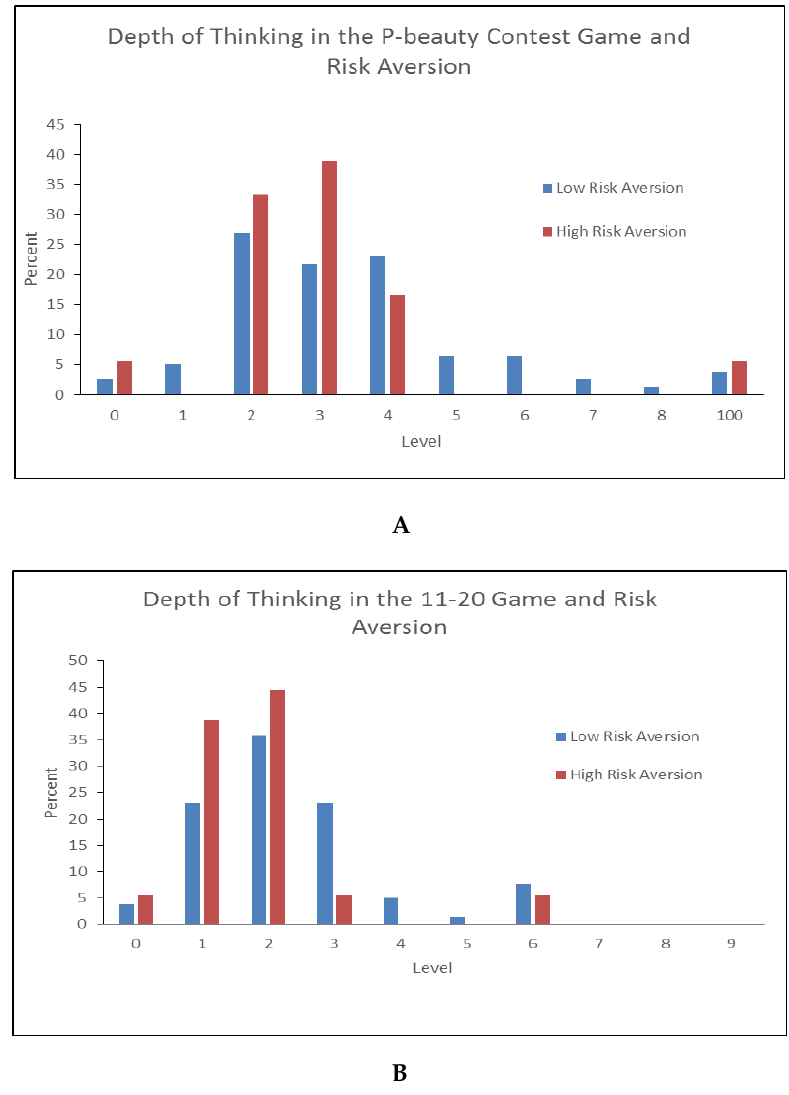
Figure A1. Depth of Thinking and Risk Aversion. ( A ) Depth of Thinking in the P-beauty Contest Game and Risk Aversion; ( B ) Depth of Thinking in the 11–20 Game and Risk Aversion.